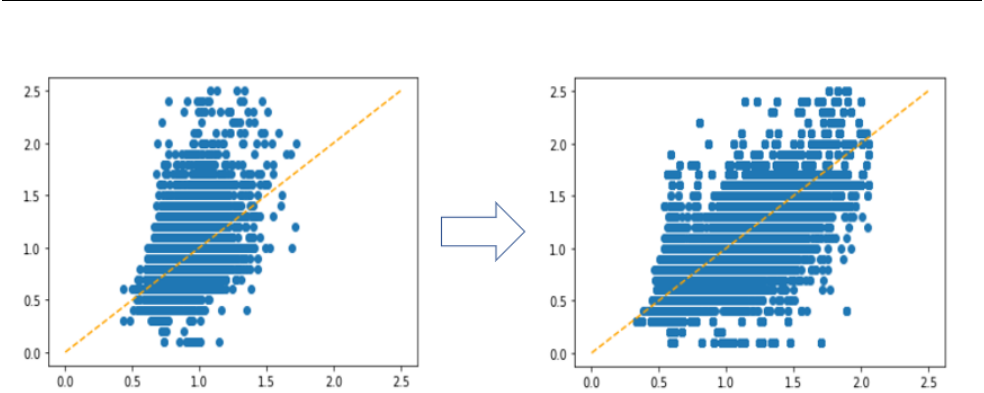
Figure 9. Effect of undersampling and cost-sensitive